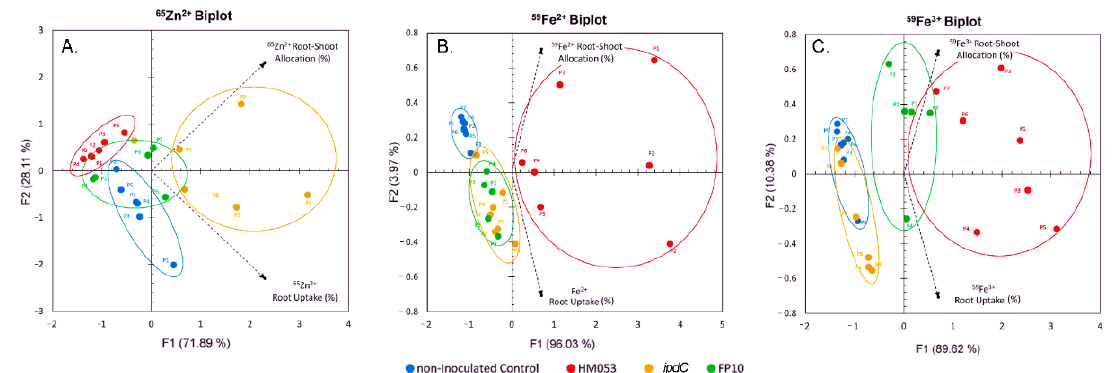
Figure 4. Principal Component Analysis correlates 65 Zn uptake and root–shoot allocation (Panel A ) to the biological functions of the beneficial microbes. HM053 and FP10 mutant strains were most like non-inoculated plant behavior, while ipdC was dissimilar, exhibiting the highest levels of root uptake and transport. Statistical correlations were made to 59 Fe 2+ (Panel B ) and 59 Fe 3+ data that we acquired in prior work [16].